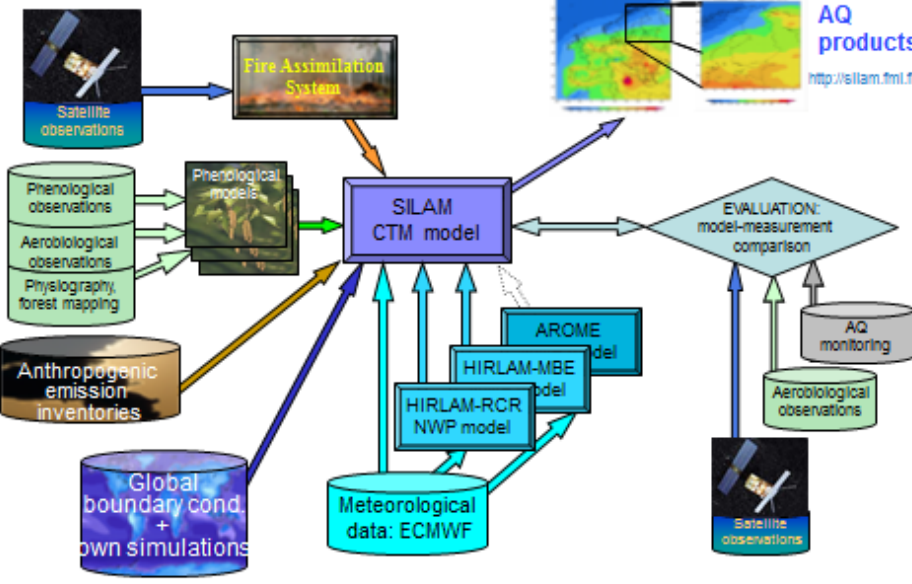
Fig. 3. The components, input and output data, and model evaluation of a regional chemical weather assessment and forecasting model Fig. 3. An example of the components in a regional chemical weather assessment and forecasting platform for an off–line chemistry transport model SILAM.